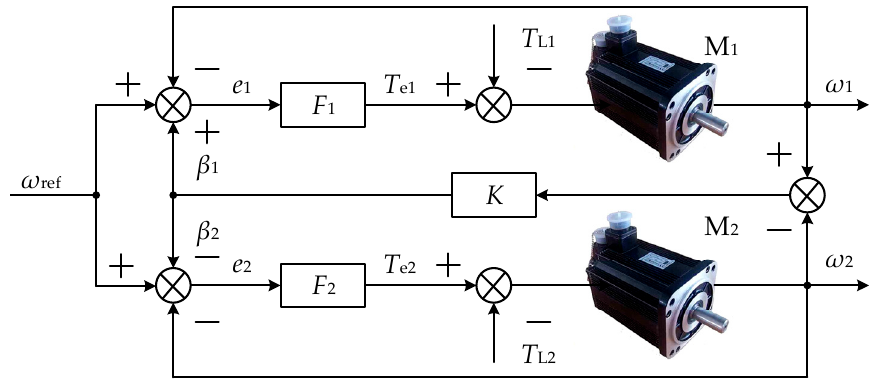
Figure 1. Traditional cross-coupling control structure.